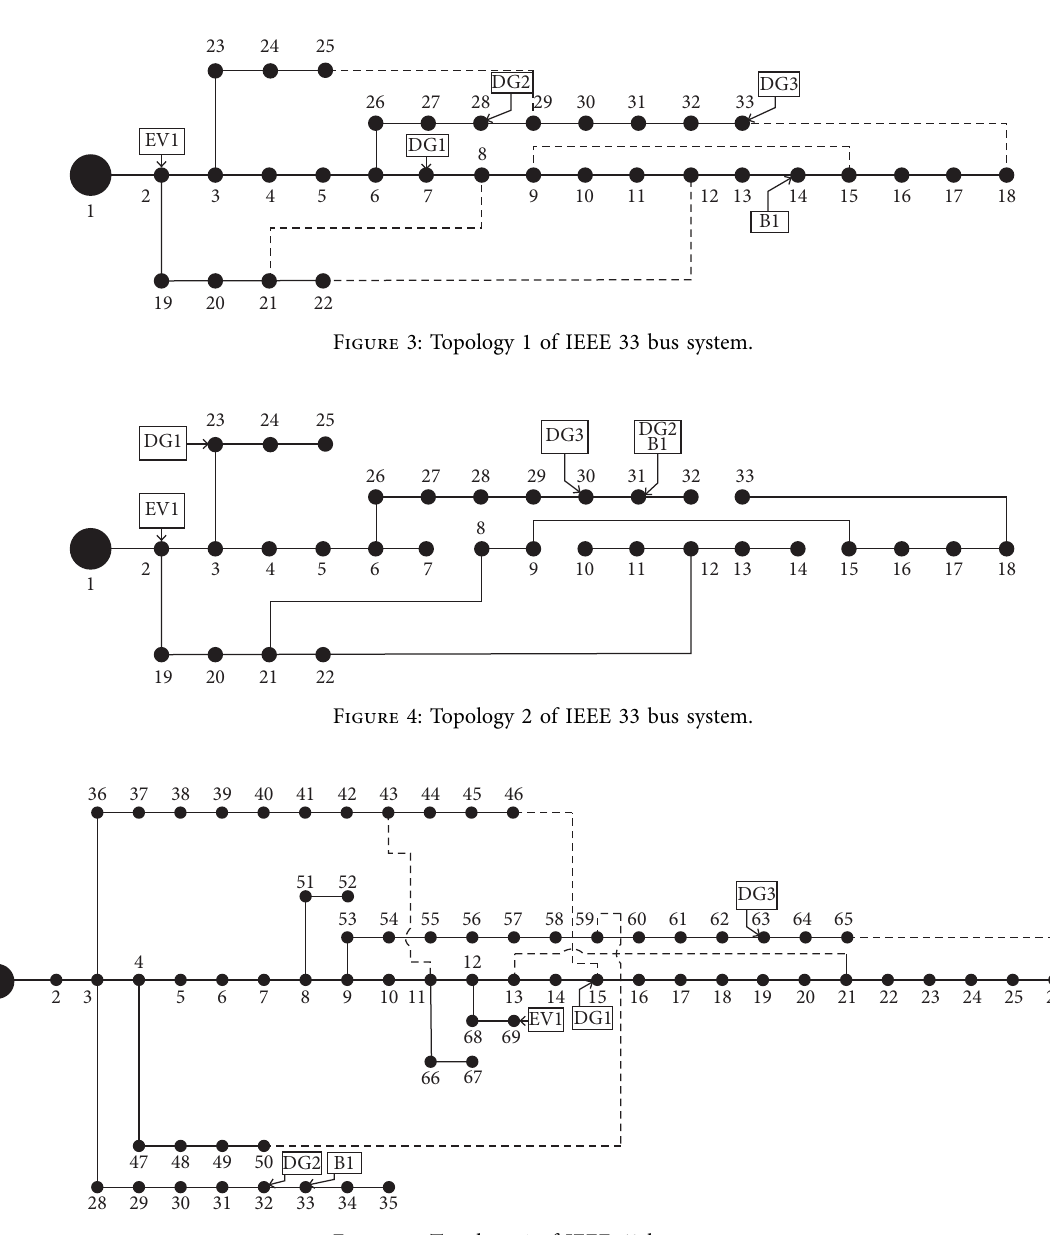
Figure 5: Topology 1 of IEEE 69 bus